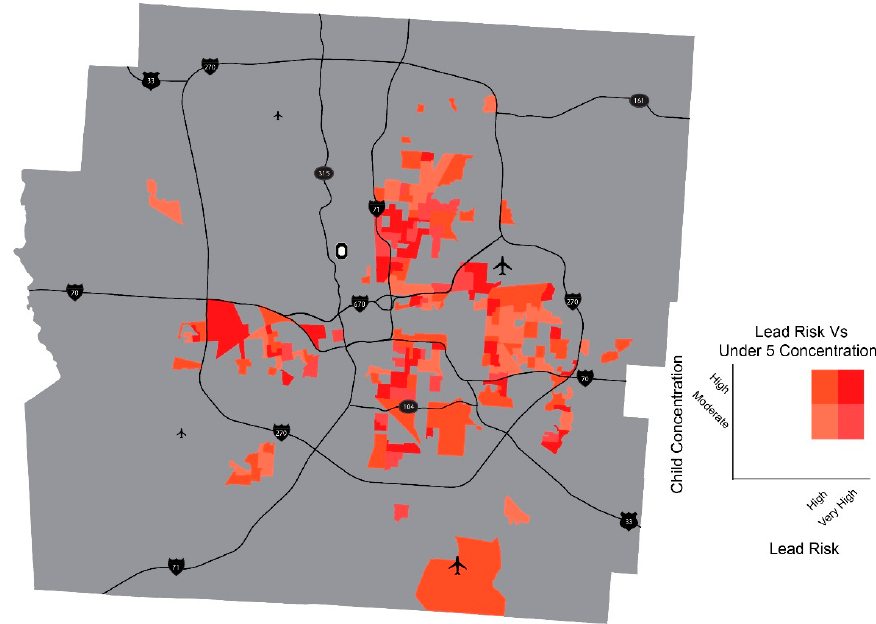
Figure 5 . High lead risk areas with more concentration of children under 5 . By adding a layer of data depicting the population of children to the lead risk distri ‐ bution, this map can be useful tool for child ‐ focused public health interventions and pol ‐ icymaking. For pediatricians planning lead poisoning prevention efforts, this map pro ‐ vides target areas to administer blood lead tests among children in areas with higher lead risk and higher concentration of children. This aligns with previous research that showed benefits of a place ‐ based approach and the use of community data as ‘geomarkers’ or ‘community vital signs’ for community health risks into population health improvement [23,30–33]. While existing studies used community data at census tract or census block group level, this study improves the correctness of neighborhood lead risk assessment by using parcel ‐ level data to take into account lead risk for individual property in measuring risks for lead ‐ based paint in residential